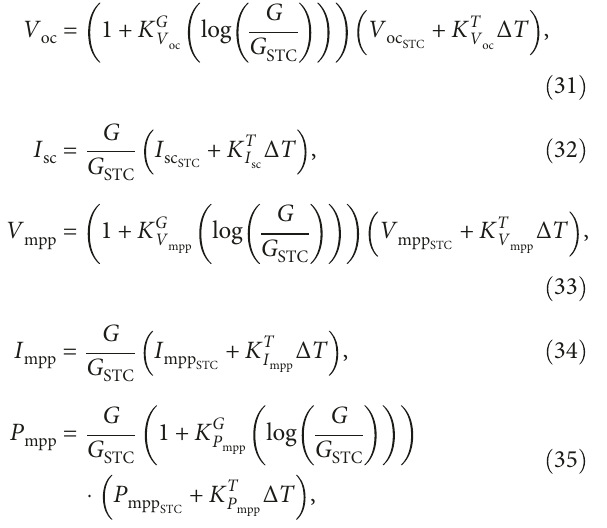
, a , I , R , and R ) of a PV module at pv STC STC 0 STC s STC p STC